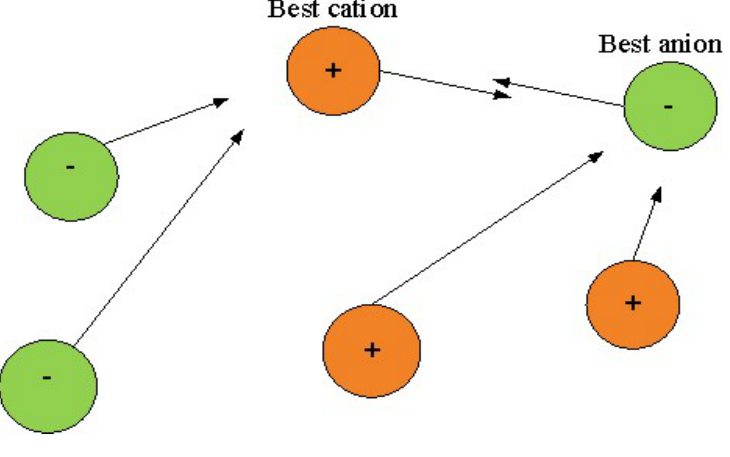
Fig. 2 . Ions movement towards the best ions in the liquid